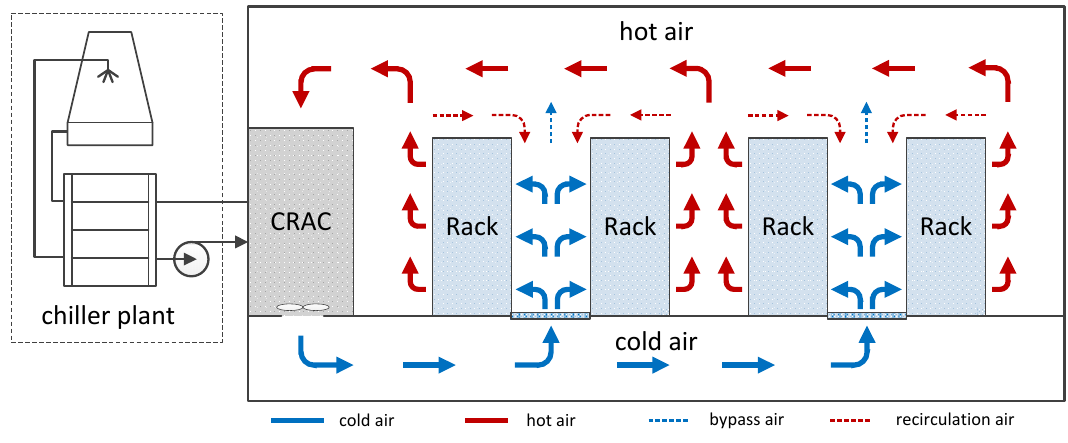
Figure 1. Typical air cooling system in data